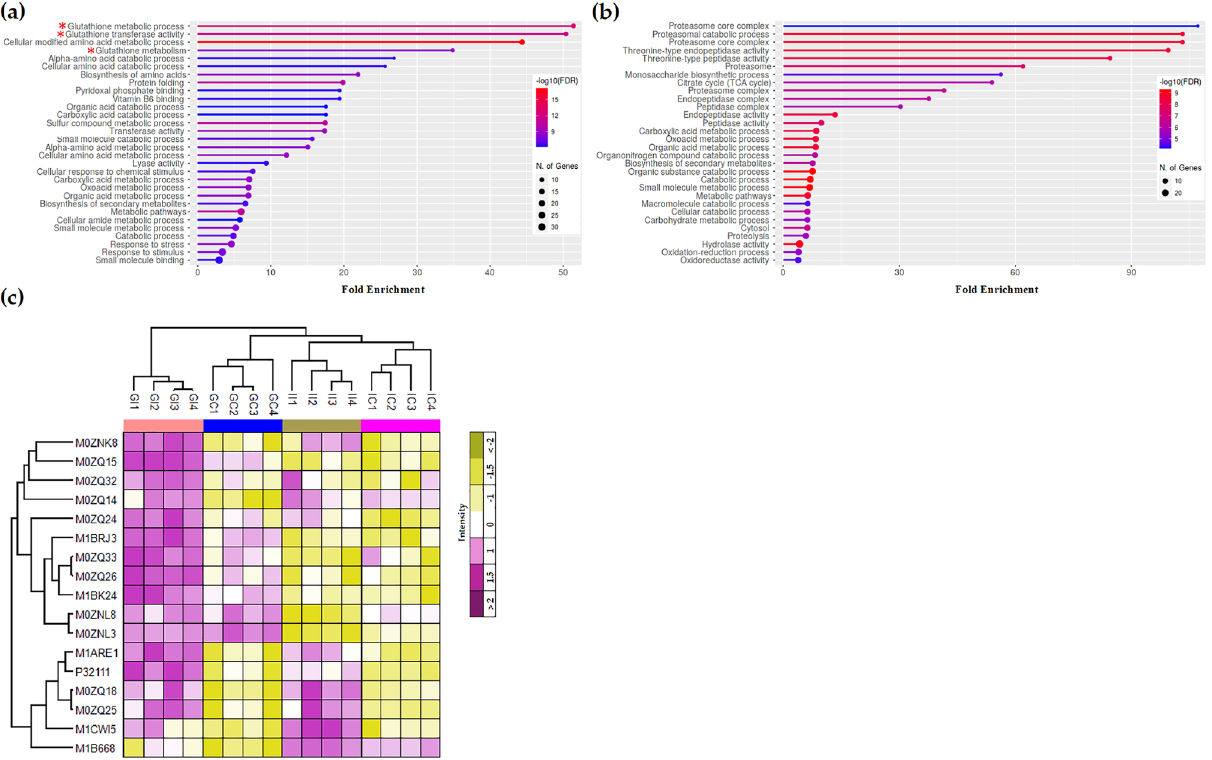
Figure 6. Functional enrichment analysis of the upregulated DAPs in ( a ) Gladiator and ( b ) Iwa. The pathways related to “glutathione metabolism” are marked with the red asterisk. ( c ) The Z-scored (normalized) expression of GST proteins among DAPs in the infected and control potato plants. GI, Gladiator infected; GC, Gladiator control; II, Iwa infected; IC, Iwa